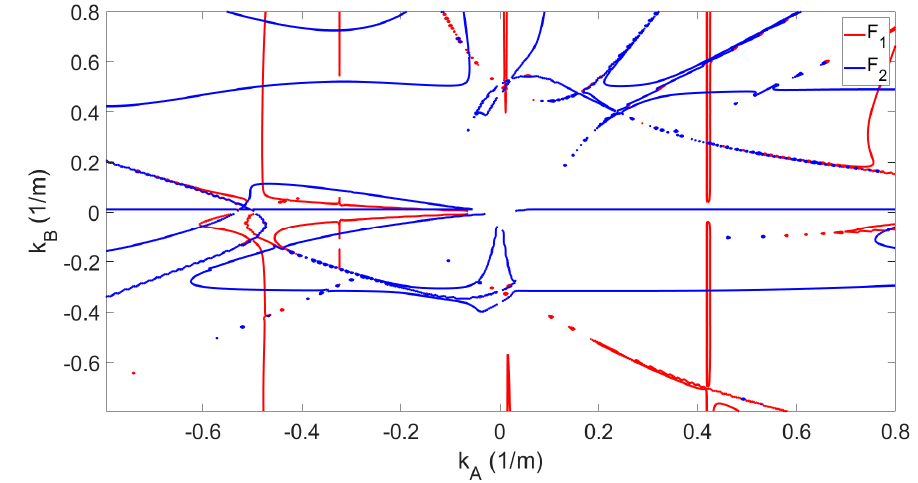
(cid:0) (cid:1) s − 1